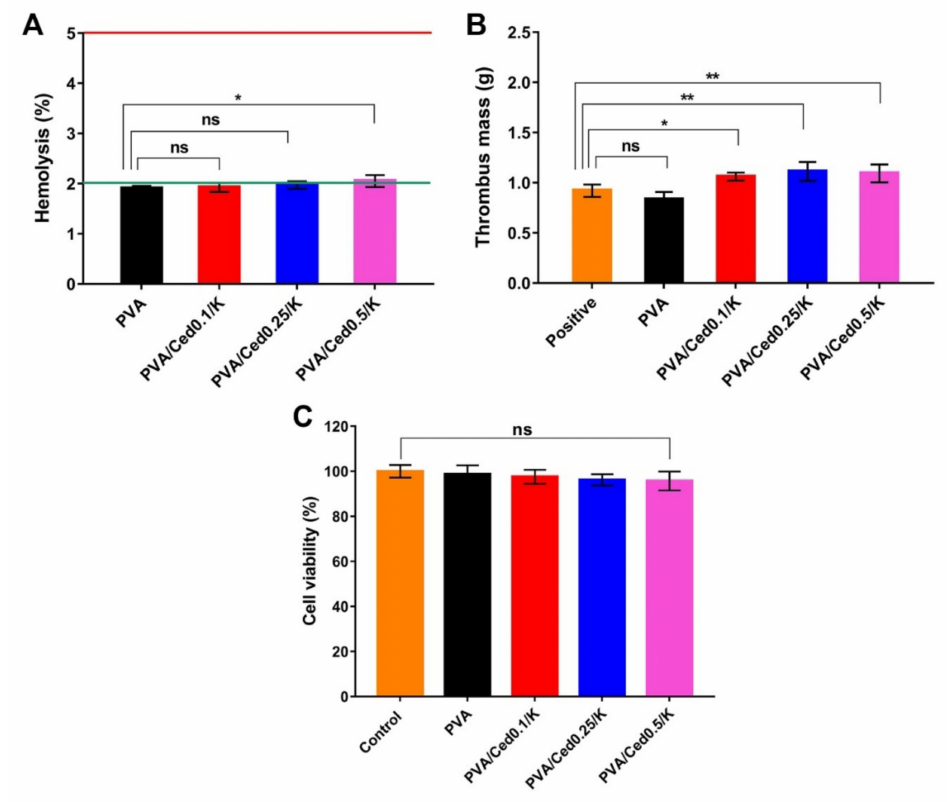
Figure 10. ( A ) Hemocompatibility, ( B ) thrombogenicity, and ( C ) cytotoxicity evaluations for PVA and PVA/Ced/K sponges. Results are expressed as mean ± SD (** p < 0.01, * p < 0.05, and ns represents a non-significant